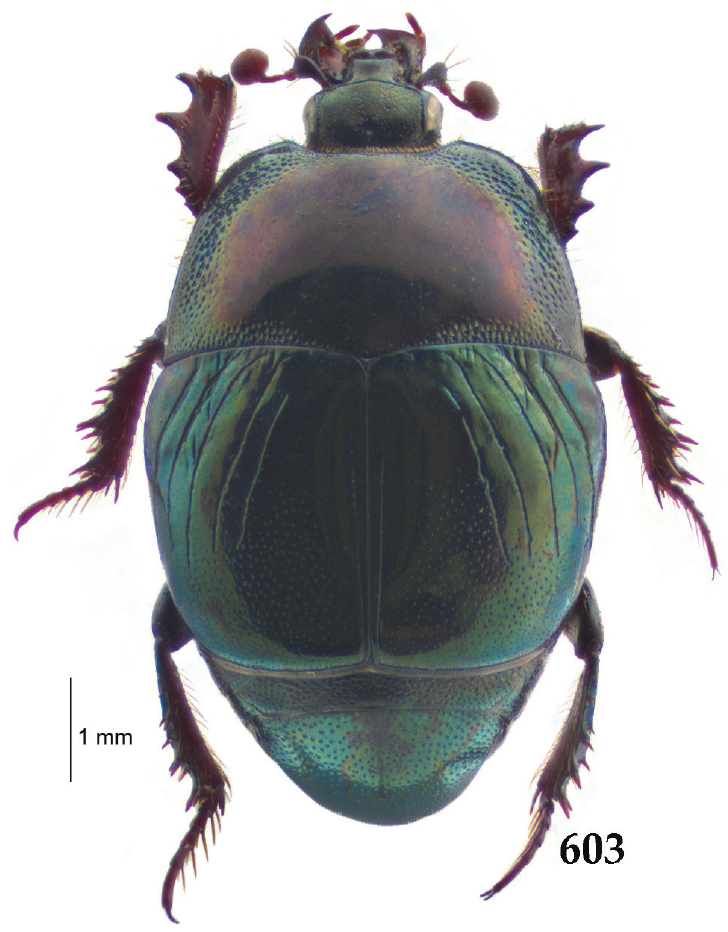
Figure 603. Saprinus ( Saprinus ) viridipennis Lewis, 1901 habitus, dorsal view. lowed by: “S. Austral.” (written); followed by: “S. Austral. / coll. Théry” (written); followed by: “Saprinus / Desbordesi / Typus / D. Auzat det 1916” (printed-written); followed by: “TYPE” (red label, printed); followed by: “Saprinus / desbordesi / Auzat, 1916 / PARALECTOTYPE / des. T. Lackner 2017” (red label, written) (MNHN, coll. Thérond). This species has been described from three specimens; two of them were from Desbordes collection and third was from Auzat’s collection (Auzat 1916). The lectotype designation fixes the species